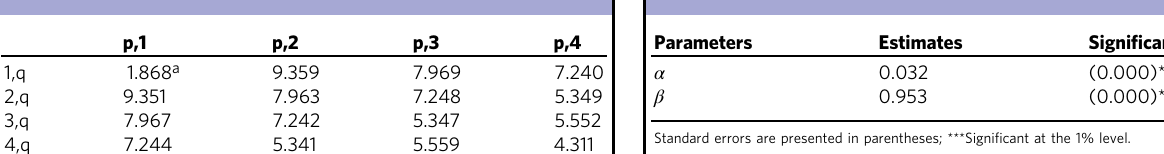
Fig. 4 Correlations among the Water Index Returns of China, Hong Kong, Japan, the Philippines, and Singapore. Table 3 Optimal GARCH (p, q) speci fi cations.